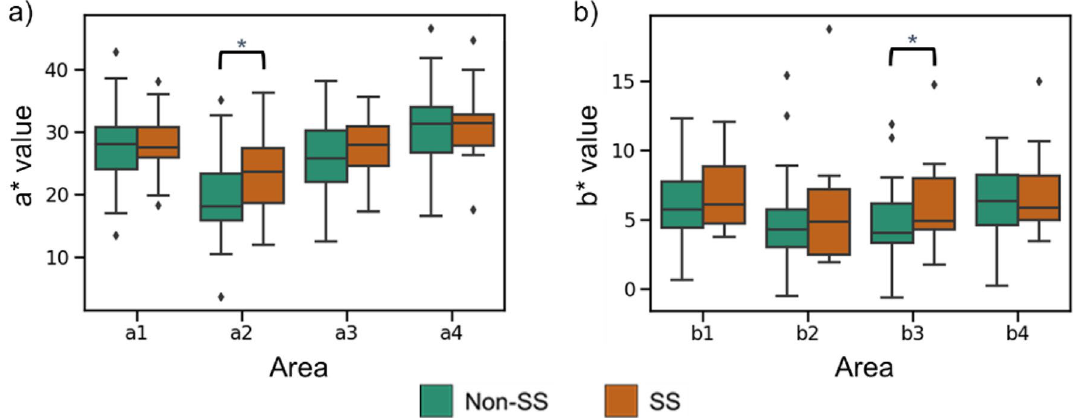
Figure 6. Comparison of the tongues of SS patients to those of non-SS patients. ( a ) a1-4 and ( b ) b1-4 indicate the a* and the b* of each tongue area defined in Fig. 2.